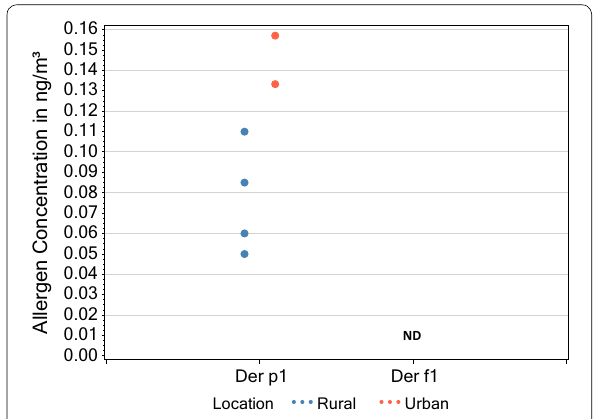
Fig. 3 Comparison of measurable (above the LoD) mite allergen airborne concentrations in the lounges of rural and urban homes (Respective rural and urban sample sizes (n) were 4 and 2 for Der p1). Statistical analysis (T-test unpaired 2 t-tailed) comparing rural and urban measurable values P 0.042. ND not detected above the = = LOD